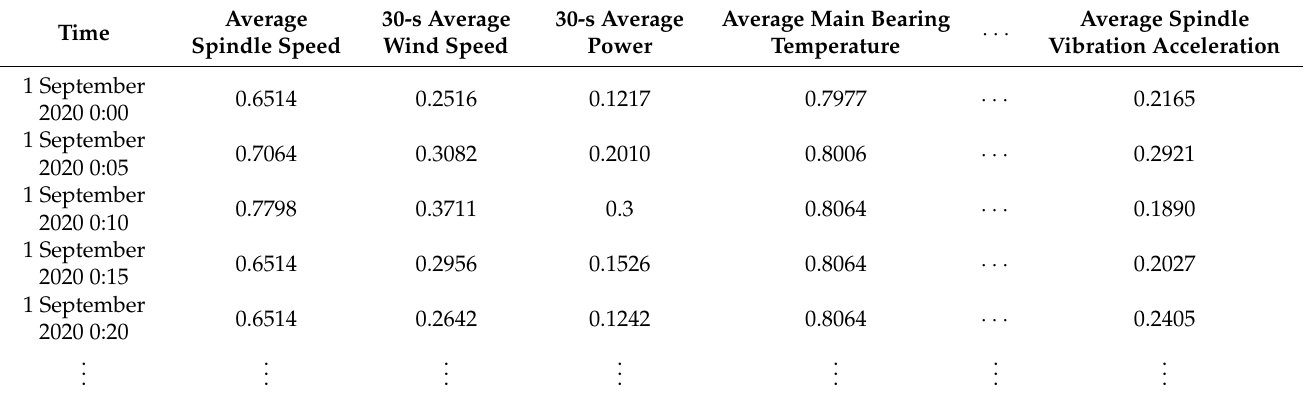
Table 4. Normalized